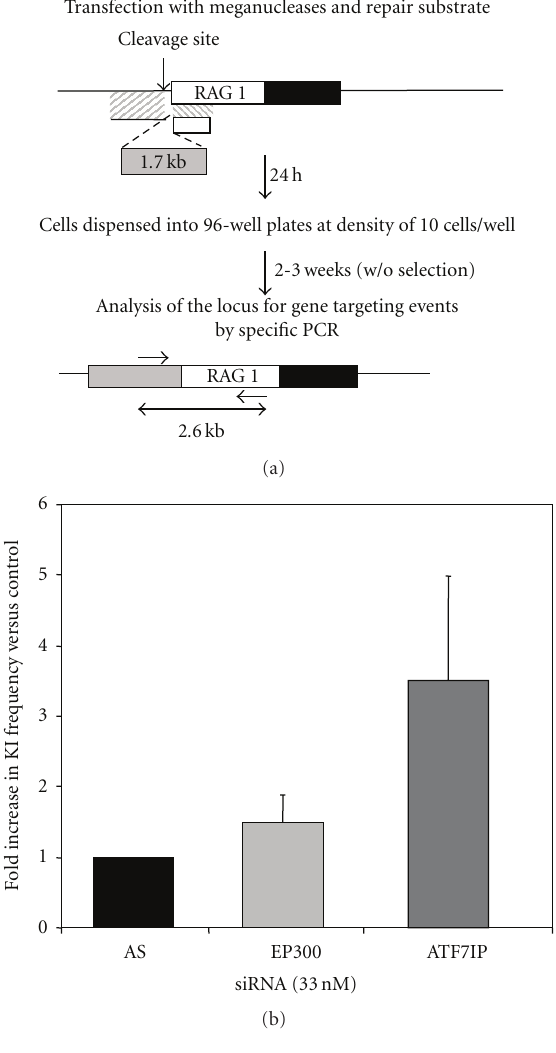
Figure 6: Impact of EP300 and ATF7IP knockdown on the frequency of targeted integration at the endogenous RAG1 locus. (a) Experimental design. (b) Results . Mean stimulationof targeted inte- gration events. The stimulation factor is expressed with respect to control siRNA (AS). Data were obtained from 4 and 3 independent experiments with EP300 siRNA and ATF7IP siRNA,